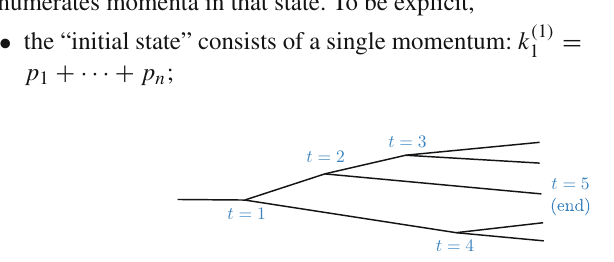
the clustering tree. Subsequent probabilities are conditioned on the out- comes from previous steps, so this decomposition entails no loss of